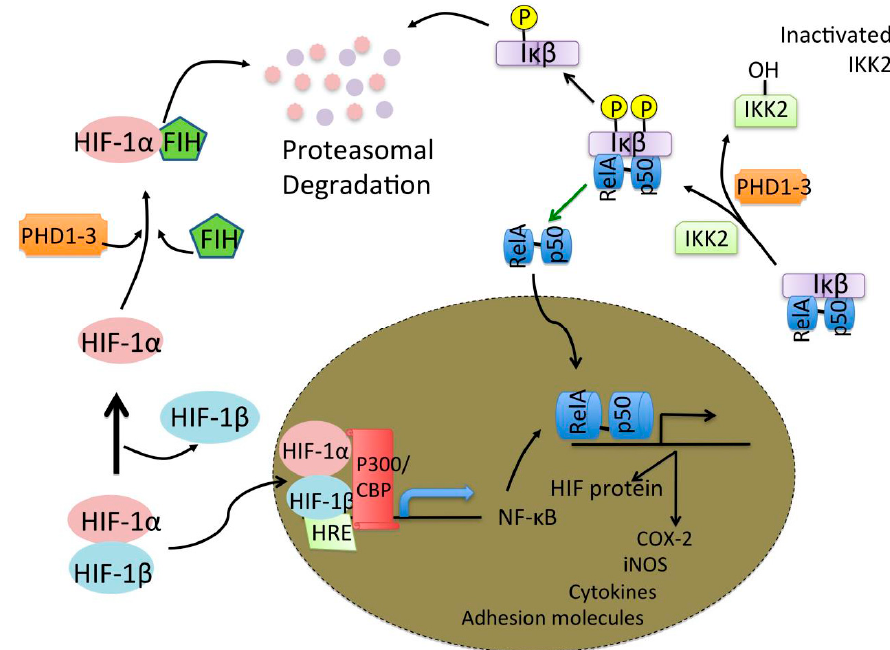
Figure 2. Hypoxia and NF κ B activation. During hypoxic HIF-1 α binding to the HRE induces the expression of NF κ B ( left ). NF κ B p50 p65 dimer is able to freely activate the transcription of the inflammatory and HIF proteins ( right ).